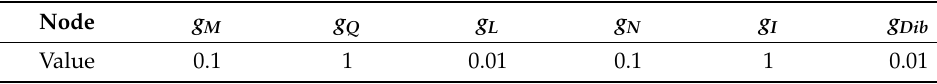
Table 14. Relative cost coefficient values in Topology